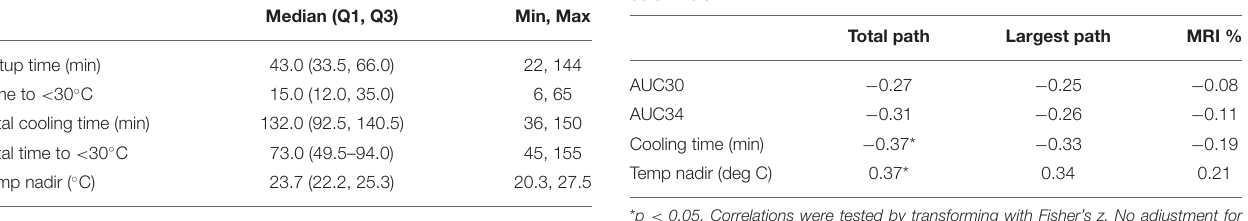
TABLE 4 | Pearson correlations between cooling parameters and outcomes on all 30